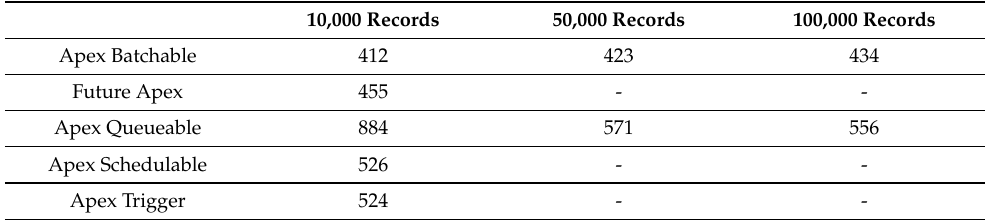
Table 14. The number of records processed in one second for delete